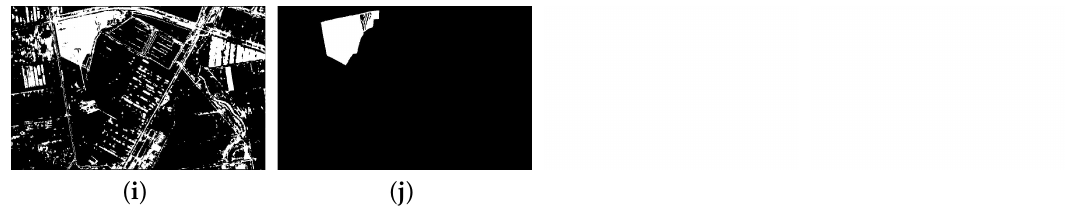
Figure 22. Difference images and resulting images for the Shuguang Village dataset obtained by different methods. ( a ) Difference image by CVA. ( b ) Difference image by ASDNN. ( c ) Difference image by SCCN. ( d ) Difference image by our proposed method. ( e ) Resulting image by CVA. ( f ) Resulting image by ASDNN. ( g ) Resulting image by SCCN. ( h ) Resulting image by our proposed method. ( i ) Resulting image by PCC. ( j ) Reference image.